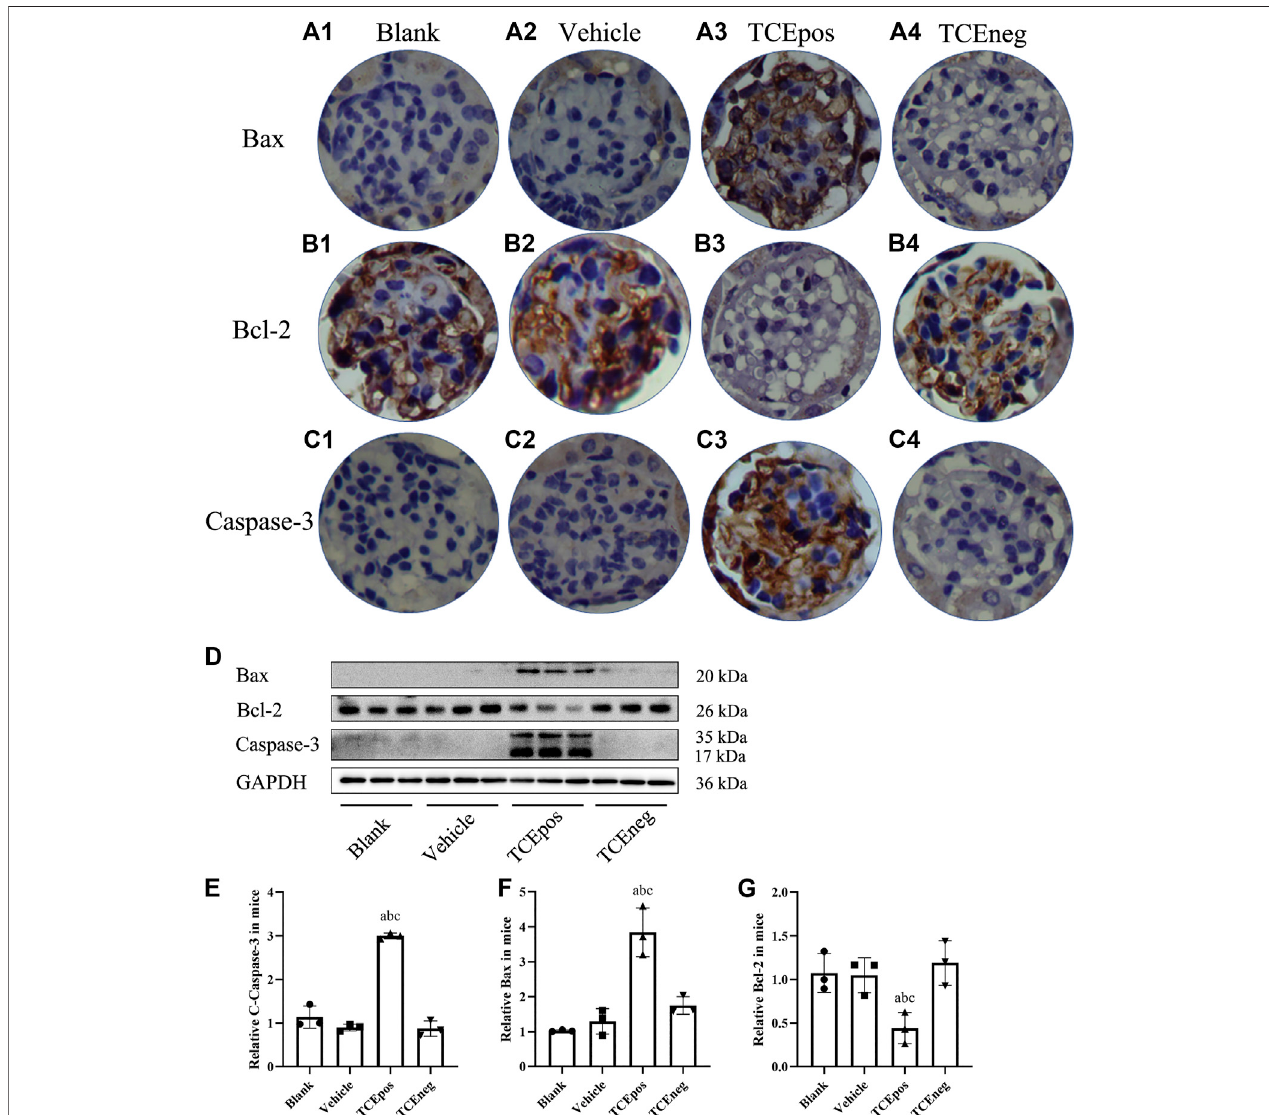
FIGURE 5 | Activation of Bax/Bcl-2/caspase-3 pathway in TCE-induced glomerular damage. (A1 – A4) Expression of proapoptotic molecule Bax; (B1 – B4) expression ofanti-apoptoticmoleculeBcl-2; (C1 – C4) expressionofproapoptoticmoleculecaspase-3inblankcontrolgroup,vehiclecontrolgroup,TCEposgroup,and TCEneggroup ( n (cid:1) 5per group). (D) Western blot bands ofBax, Bcl-2, and caspase-3 inblank control group, vehiclecontrol group, TCEposgroup, and TCEneg group ( n (cid:1) 3 per group). (E – G) Relative expression of Bax, Bcl-2, and caspase-3 calculated by gray values in image J software in above groups. Data are presented as mean ± SD and determined by one-way ANOVA, a P < 0.05, vs. blank control group; b P < 0.05, vs. vehicle control group; c P < 0.05, vs. TCEneg group.